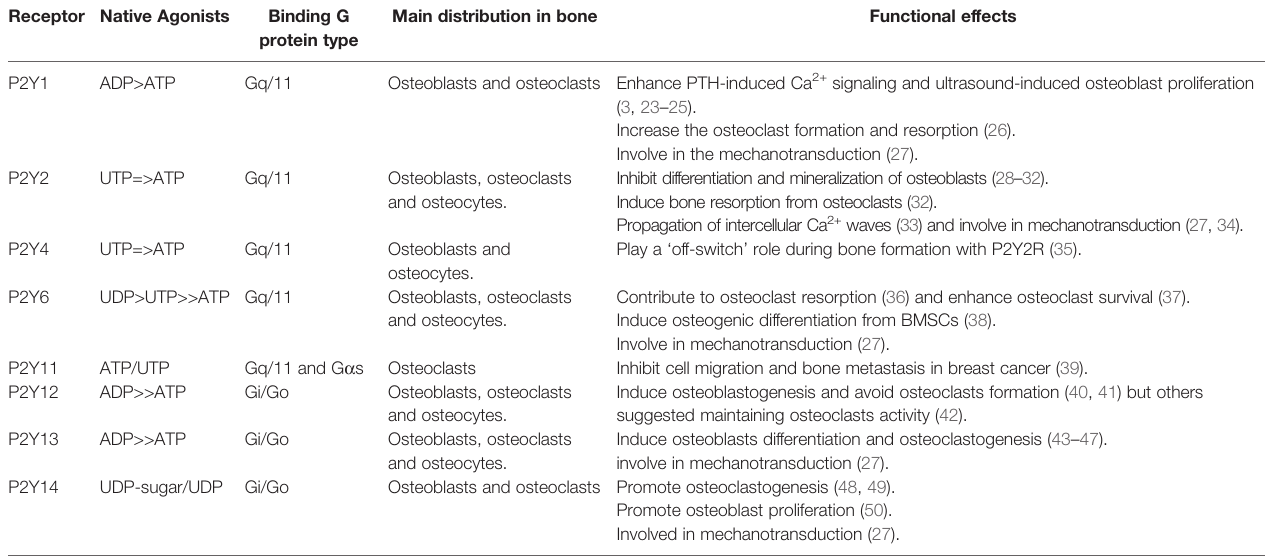
TABLE 1 | Distribution and characteristics of P2 receptors in bone. Receptor Native